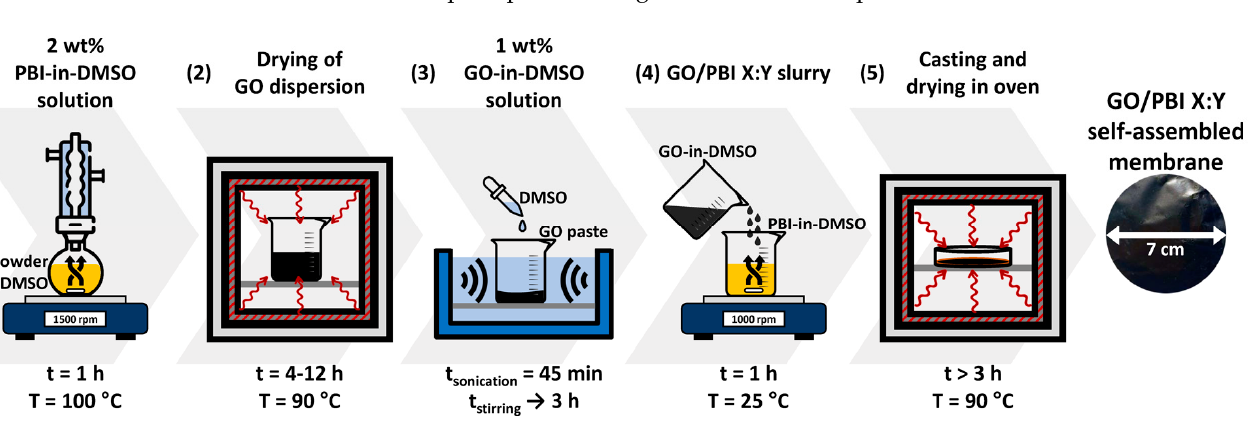
Figure 1. Preparation framework of the GO/PBI X:Y composite membranes.